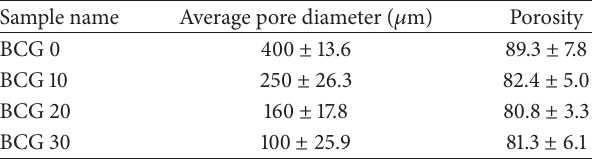
Table 4: Pore diameter and porosity of composite